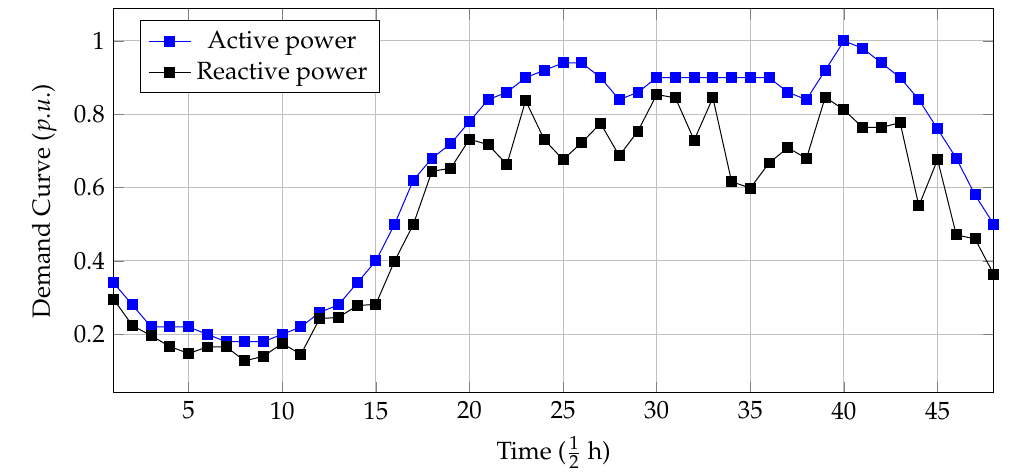
Figure 3. Daily variations for loads considering active and reactive power